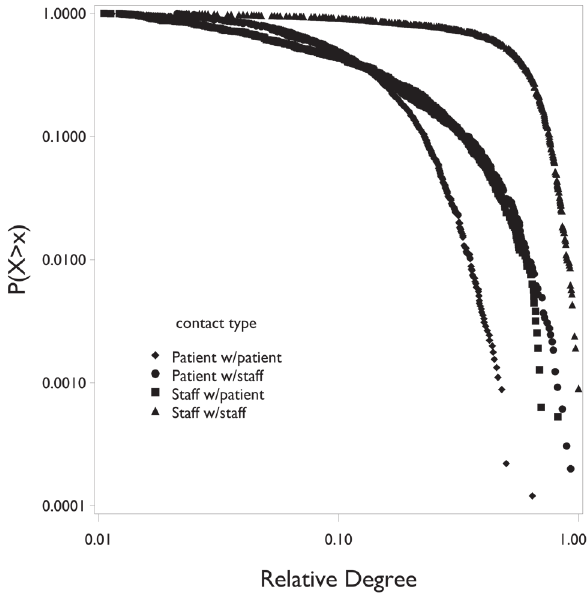
Figure 5. Cumulative distributions of number of contacts per participant (degree) by contact